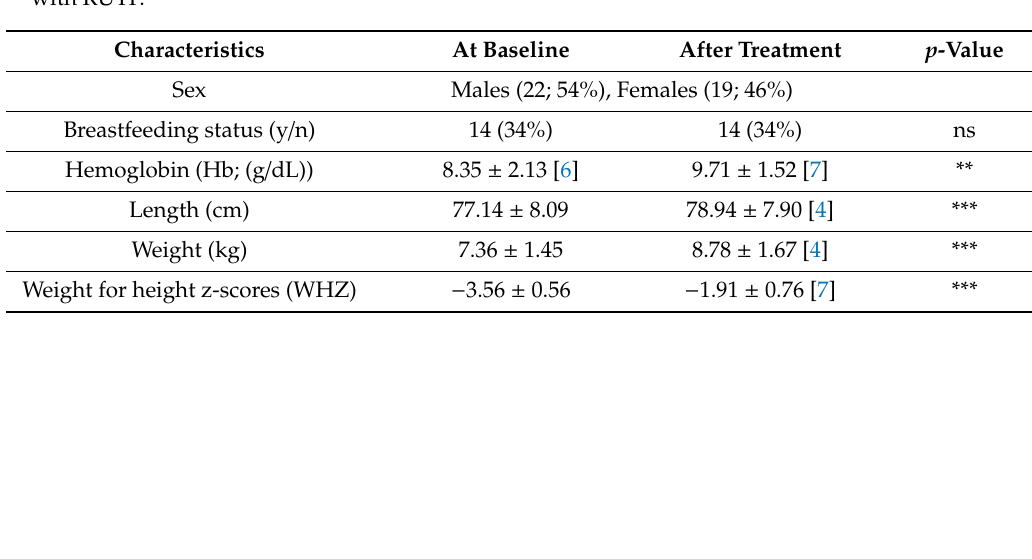
Table 2. Characteristics of the population included in the study at baseline and after treatment with